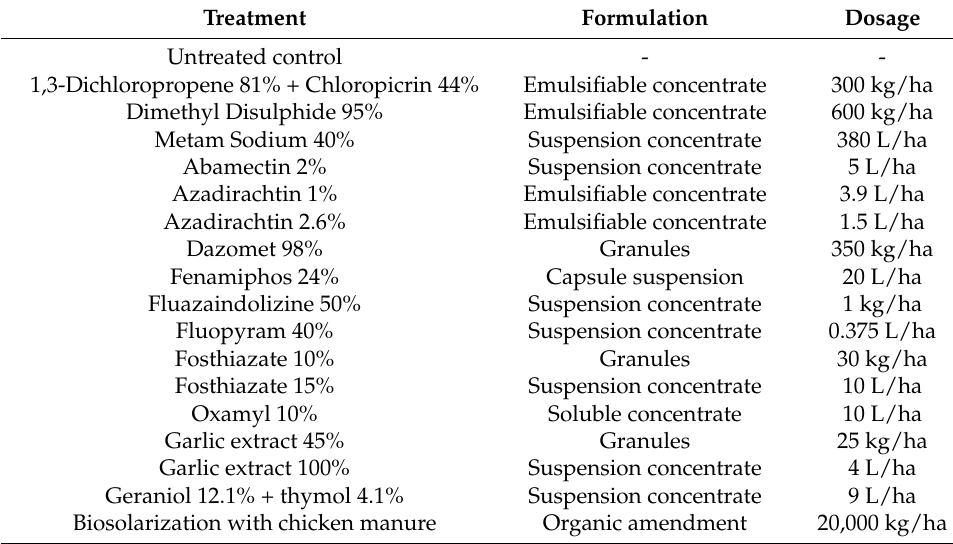
Table 8. Soil disinfestation treatments evaluated against M . incognita in field trials.